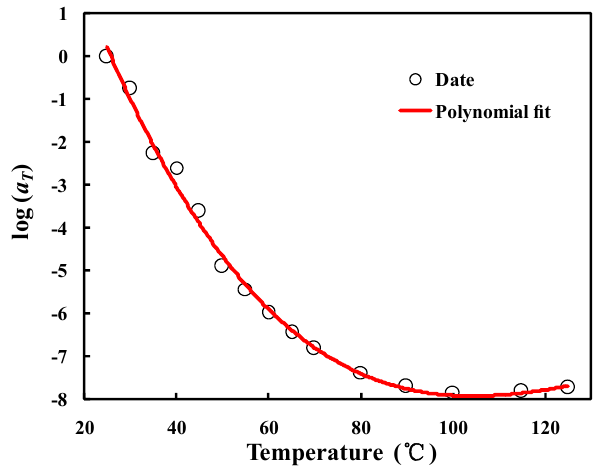
Figure 4. Master curve with reference temperature of 25 °C.